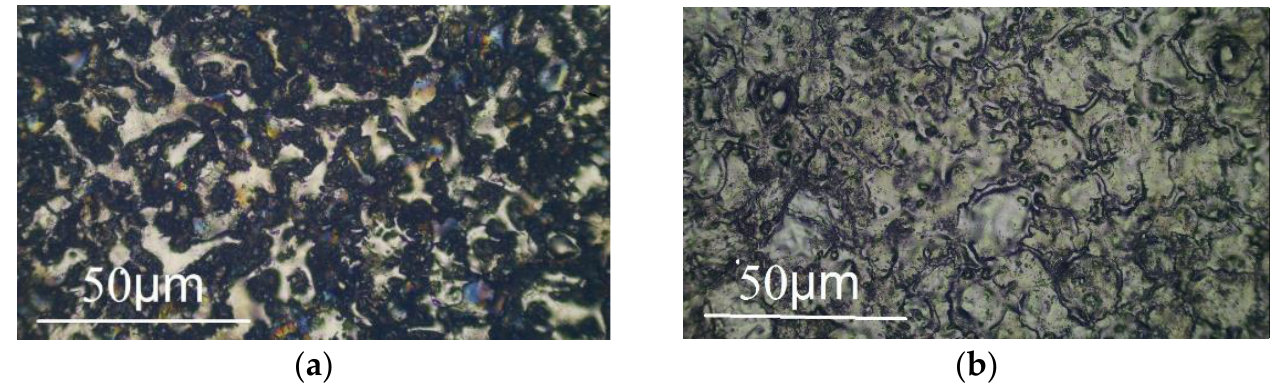
Figure 1. Topography of the coated titanium surfaces at pulse energy 0.07 J. ( a ) Coating from KW10T10B10 electrode; ( b ) Coating from TiB2–TiAlnano electrode.